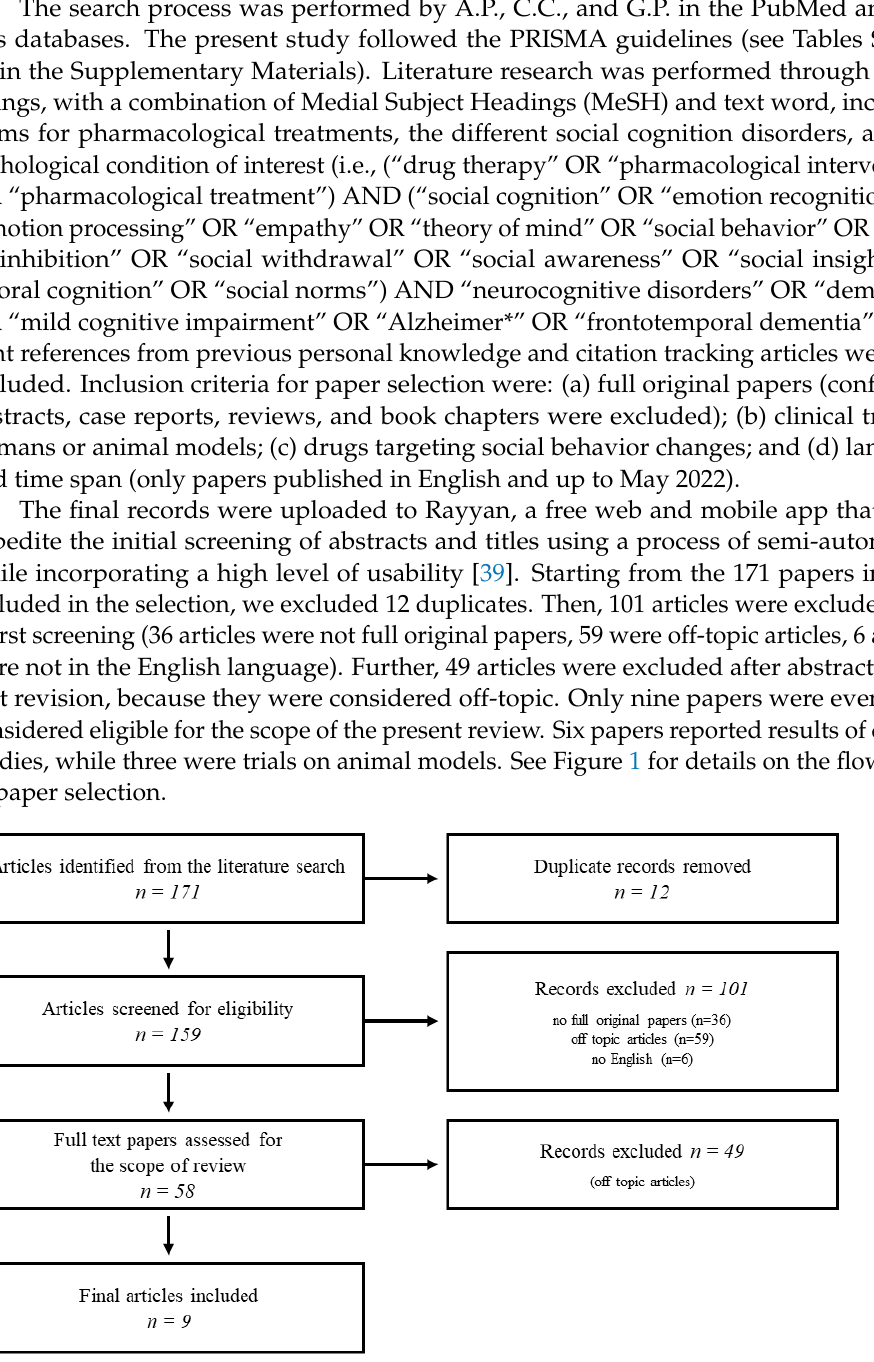
Figure 1. Flowchart of literature